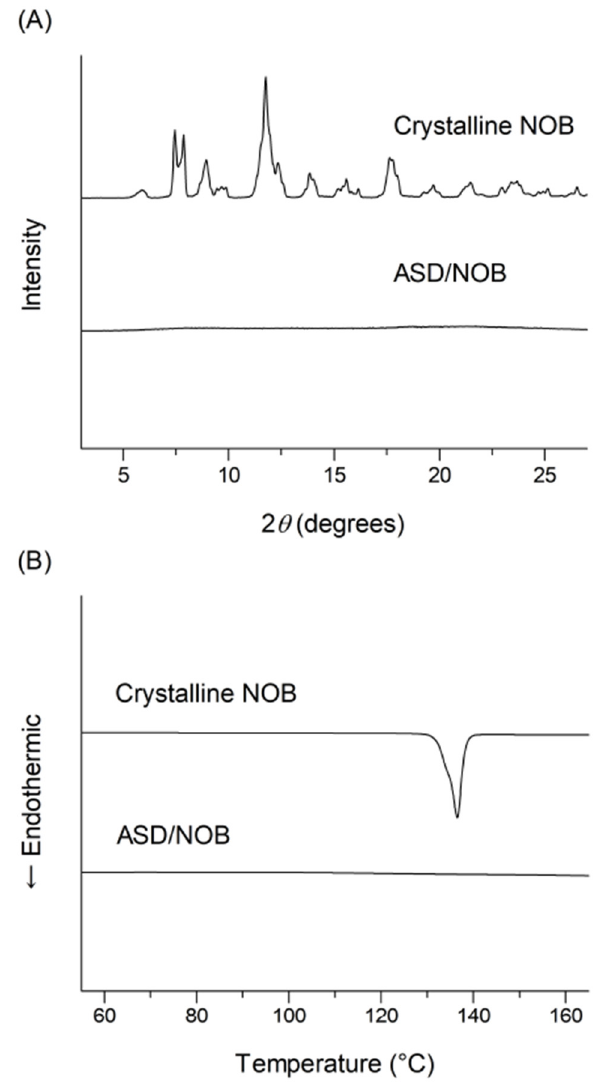
Figure 2. Physicochemical characterization of NOB samples. ( A ) Powder X-ray diffraction and ( B ) differential scanning calorimetry of crystalline NOB and ASD/NOB.